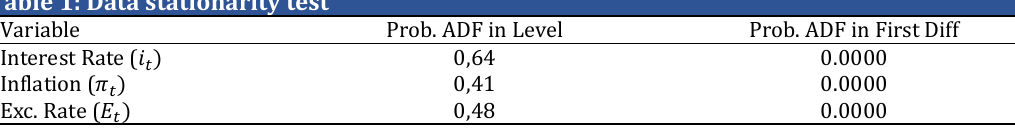
Table 1: Data stationarity